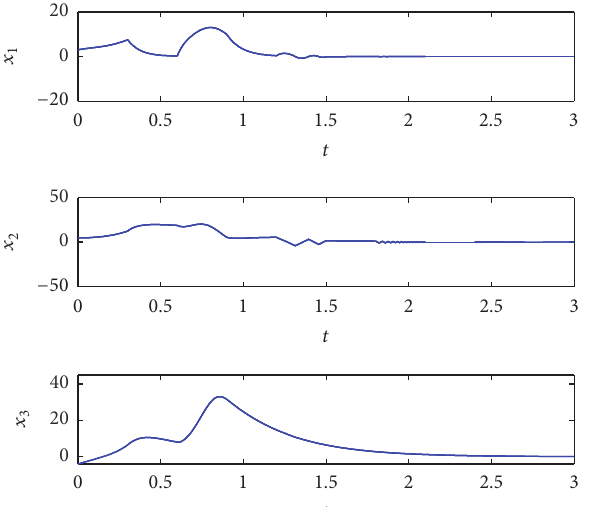
Figure 3: Orbits of controlled system (46) with 𝑥 1 (0) = 3 , 𝑥 2 (0) = 5 , and 𝑥 3 (0) = −4 .